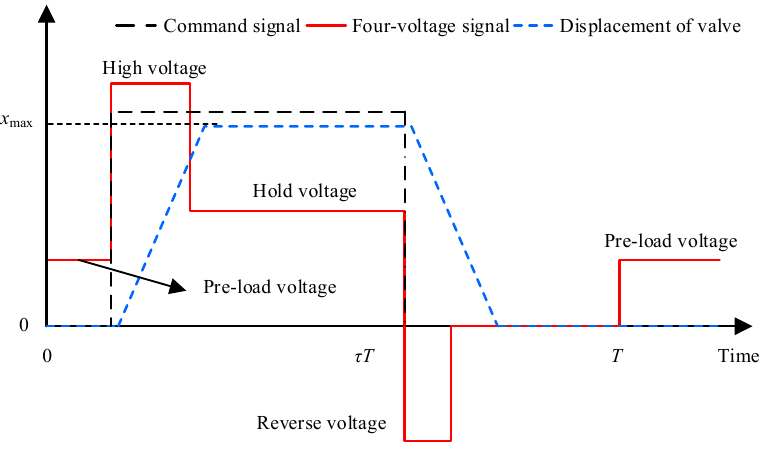
Figure 7. Diagram of four-voltage control signal.